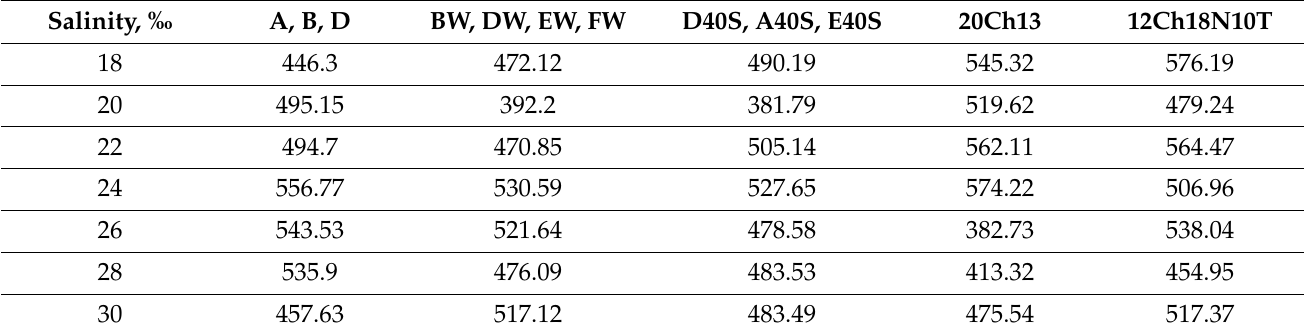
Table 3. Corrosion potential on the juvenile surface of